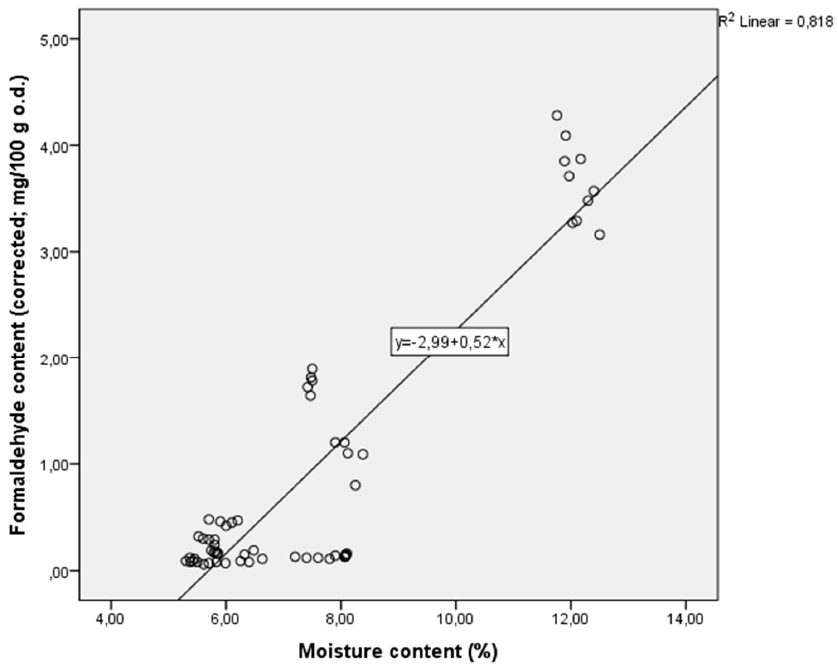
Figure 3. Normal P-P plot of regression-standardized residual for corrected formaldehyde content of larch-bark samples bonded with six types of adhesives.